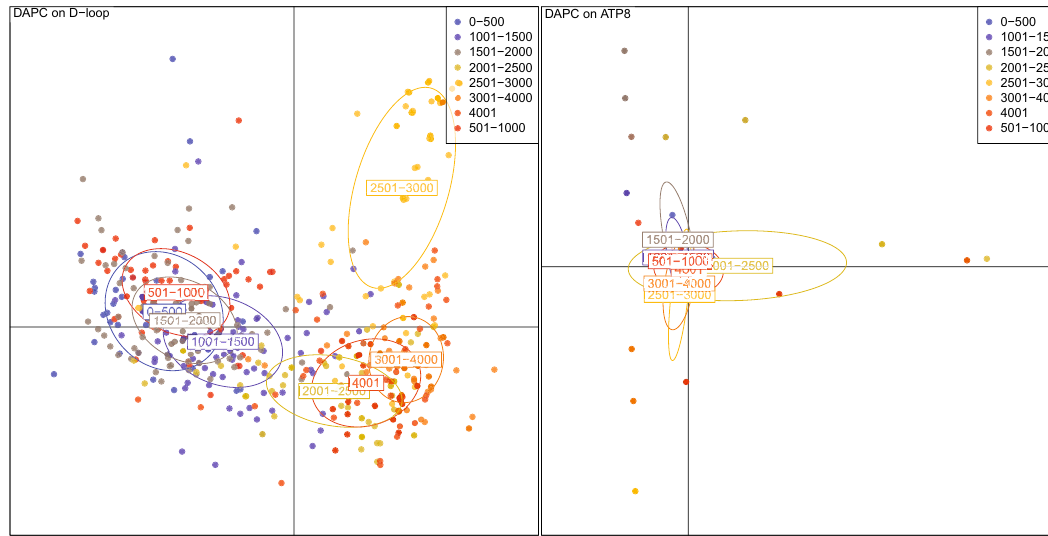
Figure 3. The 2 main Principal Coordinates, obtained by DAPC, for the D-loop (left) and ATP8 (right). Each point represents one subject, its color corresponds to the altitude group. For D-loop there are 3 main clusters, corresponding to altitudes 0-2000 m, 2501–3000 m, 2001–2500 and 3000–4001 m. For the ATP8 there are no separate clusters.